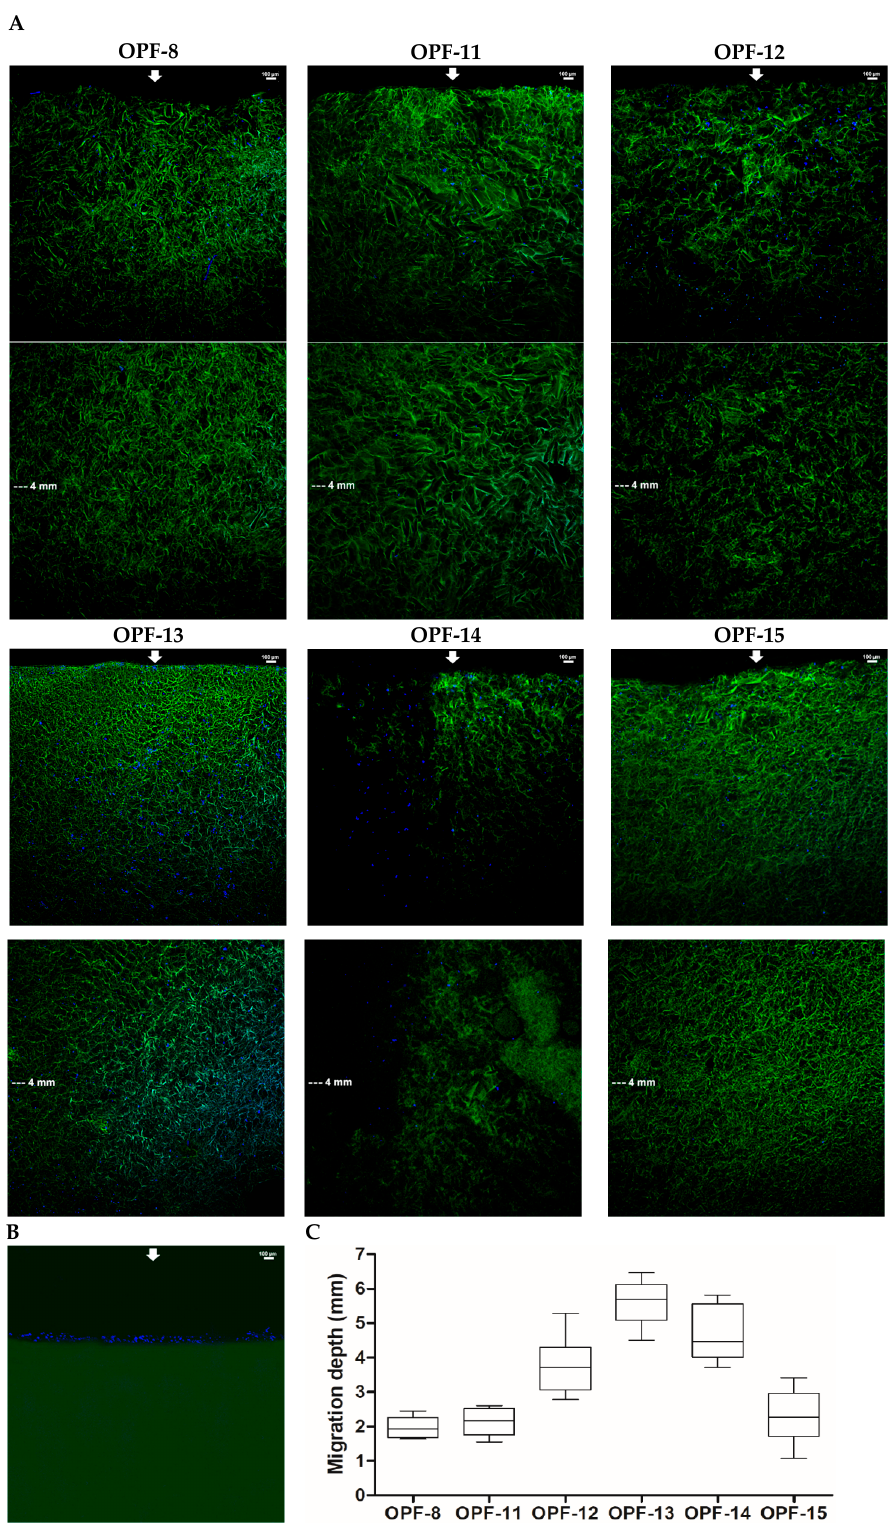
Figure 4. LSCM microphotographs of the lateral sections of OPF cryogels with a variable MAETAC amount ( A ) and an OPF hydrogel ( B ) with PC-12 cells migrating towards culture medium. The cells were incubated for 6 h on top of the materials mounted over the medium, which were fixed and stained with DAPI. The lateral sections of each cryogel were combined from the upper and lower parts; the arrows indicate cell seeding and migration sides. ( C ) The mean depth of cell migration into cryogels was shown.